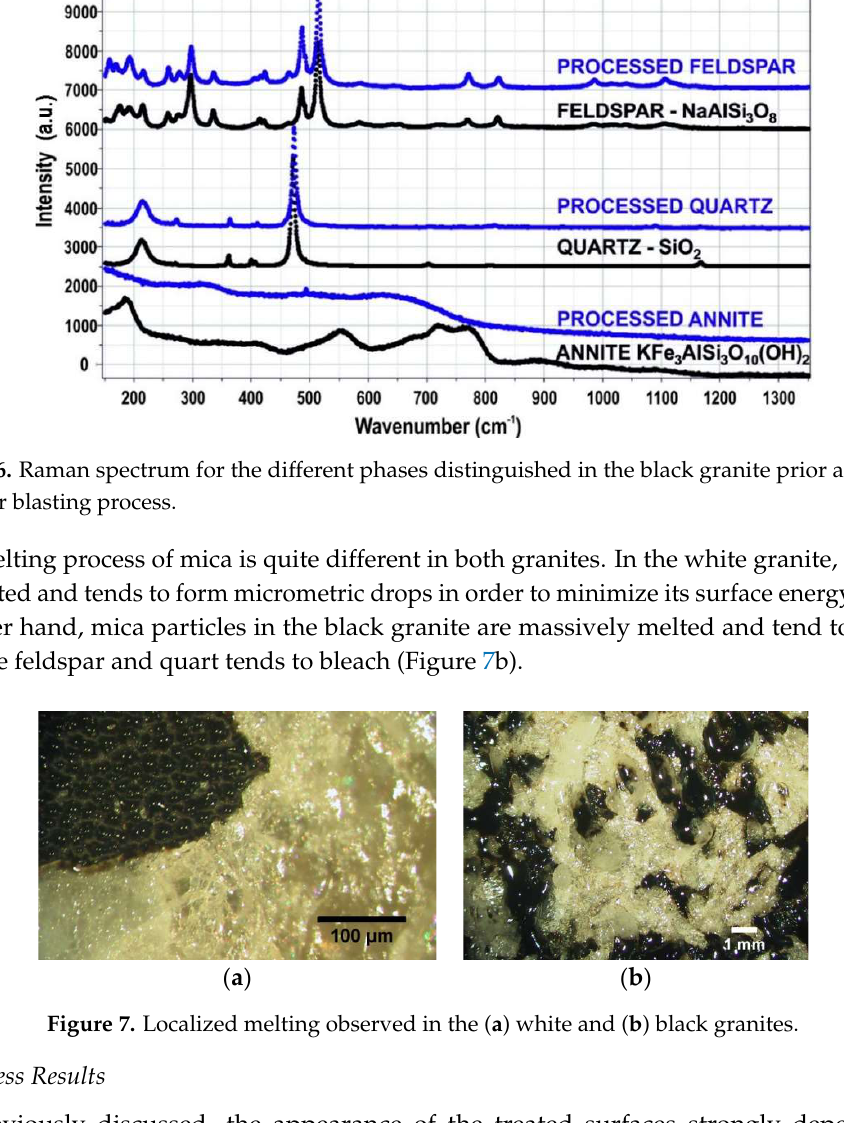
Figure 7. Localized melting observed in the ( a ) white and ( b ) black granites.